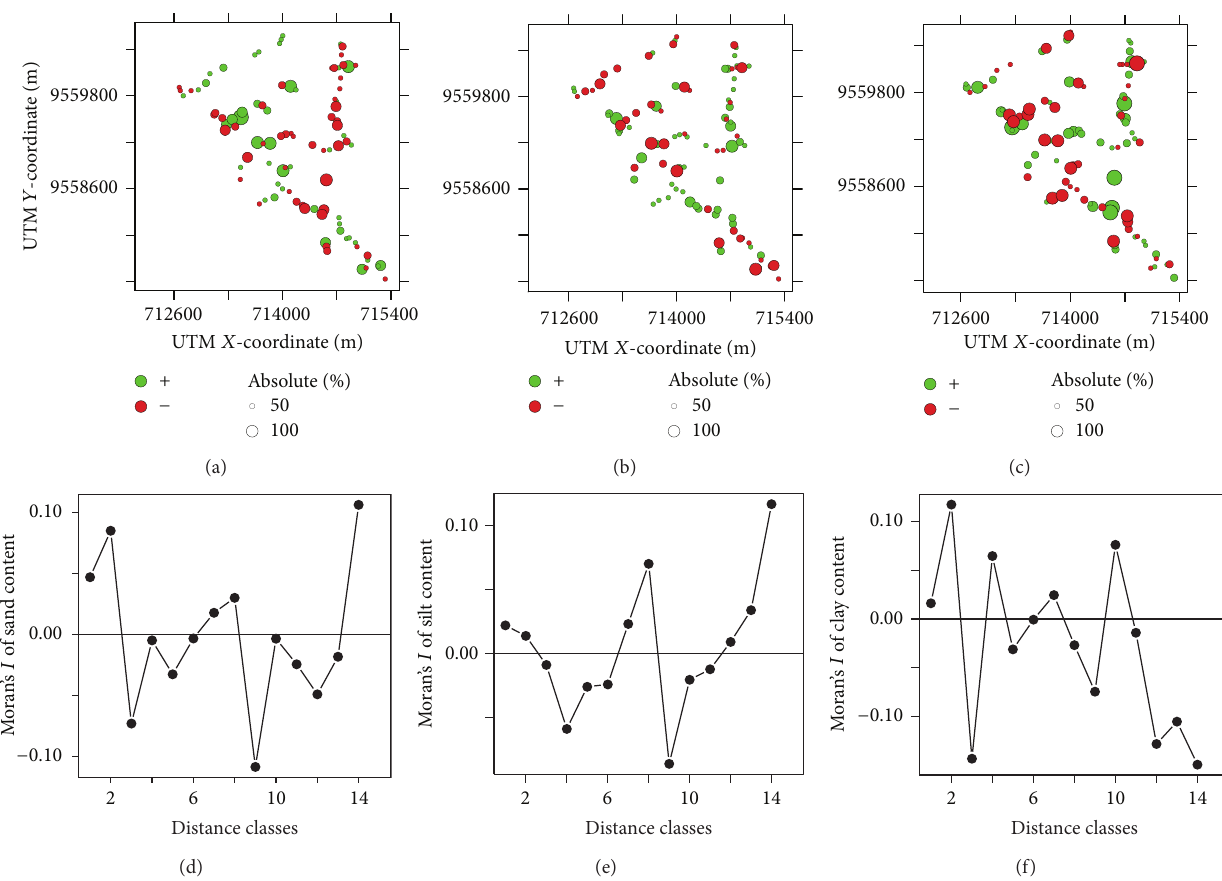
Figure 3: Spatial distribution of residuals in % of the maximum absolute residual value (red = negative values, green = positive values, top) and Moran’s 𝐼 (bottom). Models from linear regression for ((a) + (d)) sand content, ((b) + (e)) silt content, and ((c) + (f)) clay